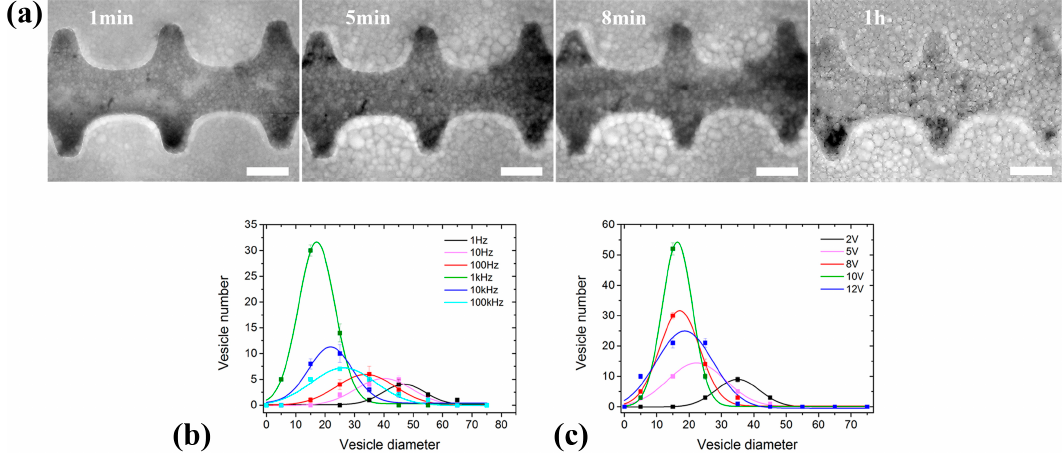
Figure 3. ( a ) The GUV formation process in the 2D electrode system at 8 V and 1 kHz. ( b , c ) The scatter diagram and Gaussian fitting curves for GUV diameters at different frequencies (8 V) and voltages (1 kHz), respectively. Where, the vesicle number was obtained in a subcell of the microchip. The GUVs with diameter within the interval of (0, 10) were classified into d = 5 μ m, and so on. The scale bar is 100 μ m.